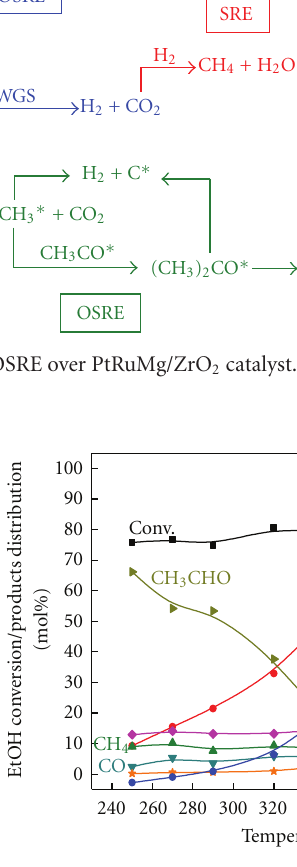
Figure 2: Catalytic performances in the OSRE reaction over PtRuMg/ZrO 2